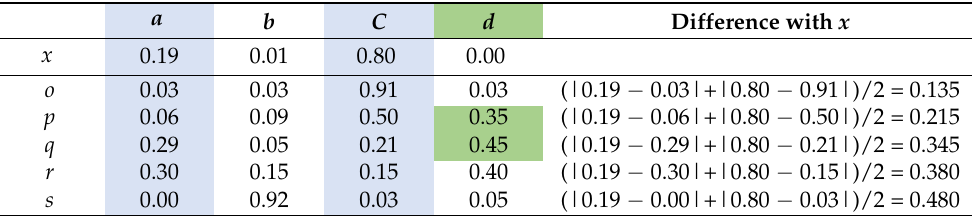
Table 2. Example of the proposed recommendation system. Rows represent the clients’ normalized vectors ( x , o , p , q , r , and s ). Columns represent restaurants ( a , b , c , and d ). Blue columns represent the preferred restaurants of client x . Green cells represent the recommended restaurant based on our recommendation